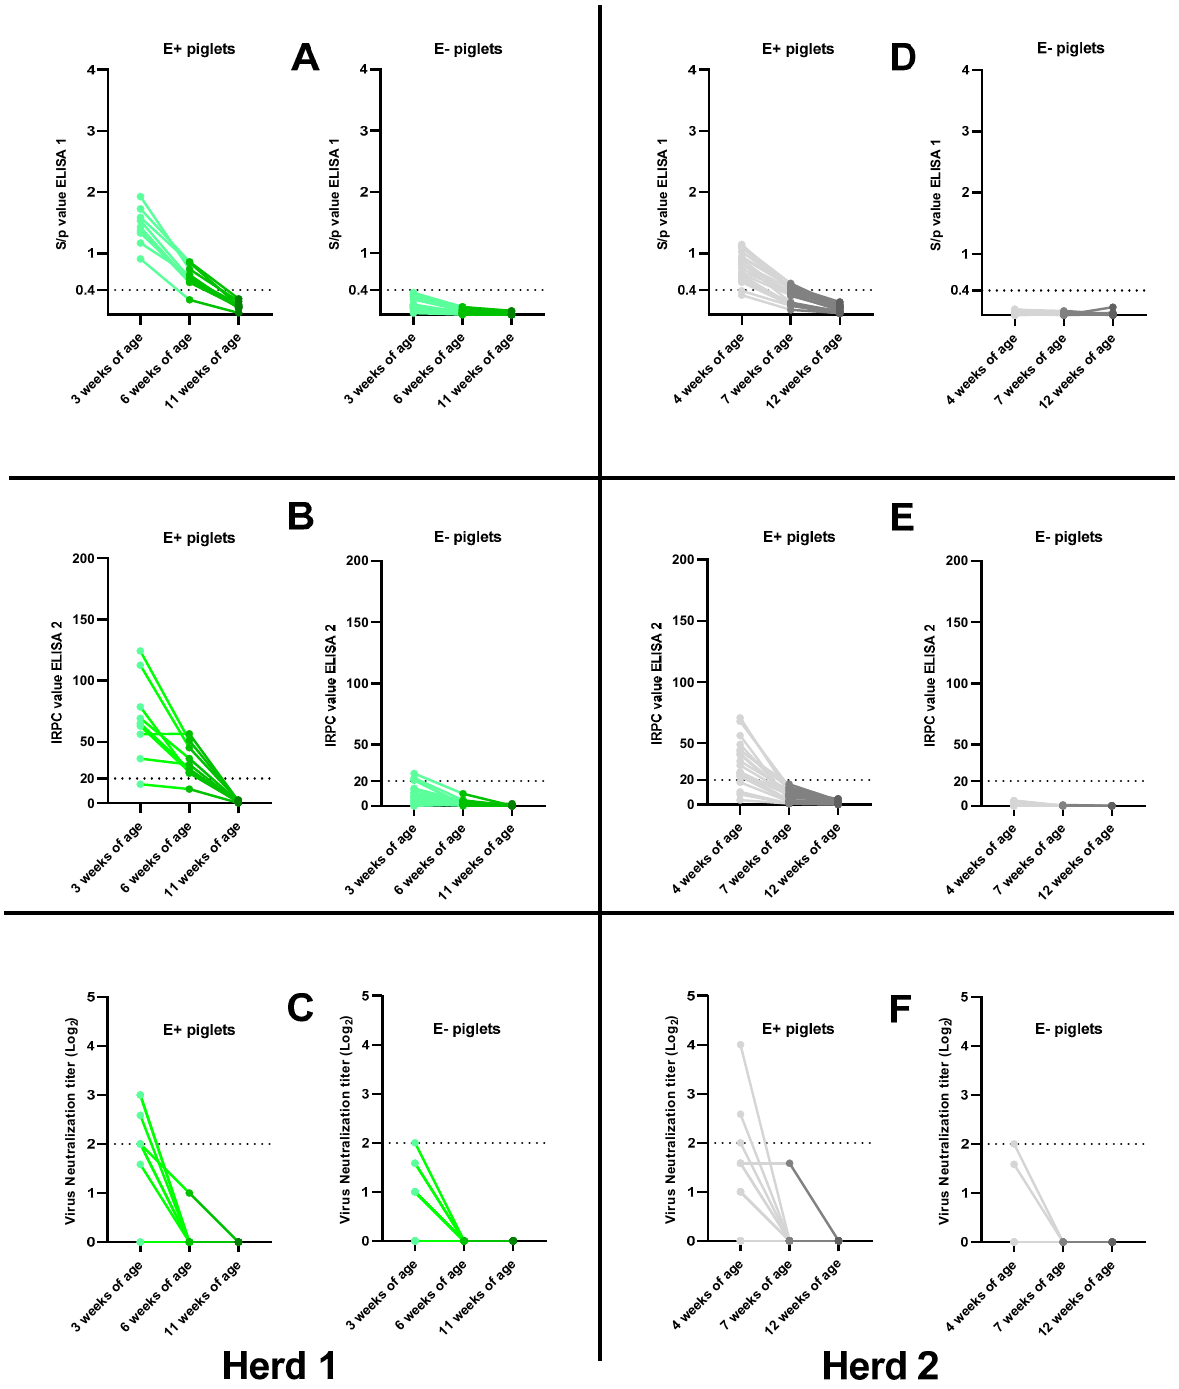
Figure 5. Serological follow-up of PRRSv-specific antibodies in unvaccinated, control piglets born from PRRSv-vaccinated seropositive sows (E+ piglets) and PRRSv-vaccinated seronegative sows (E − piglets) in two Belgian farrow-to-finish herds. Piglets in herd 1 ( A – C ) were sampled at 3, 6 and 11 weeks of age. Piglets in herd 2 ( D – F ) were sampled at 4, 7 and 12 weeks of age. All piglets were analyzed using IDEXX ELISA (A + D; ELISA 1), CIVTEST ELISA (B + E; ELISA 2) and virus neutralization assay (C + F; VN). Individual S/ p values (ELISA 1), IRPC values (ELISA 2) and Log 2 VN titers are shown as dots with lines connecting the values at each sample moment for each piglet. Cut-off values for seropositivity are included in each graph as a dotted horizontal